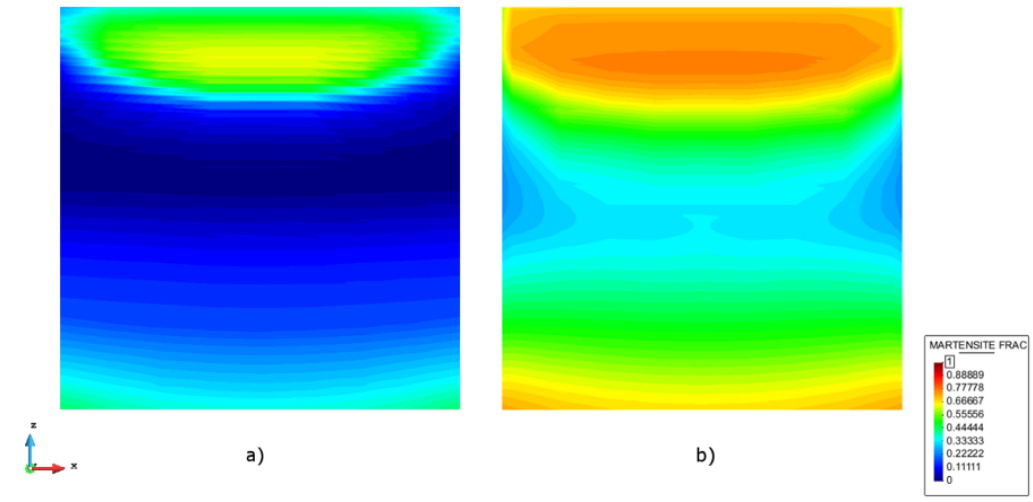
Figure 14. Contour fill of calculated final α m fraction in a vertical section xz along the middle plane of the samples S3 ( a ) and S5 ( b